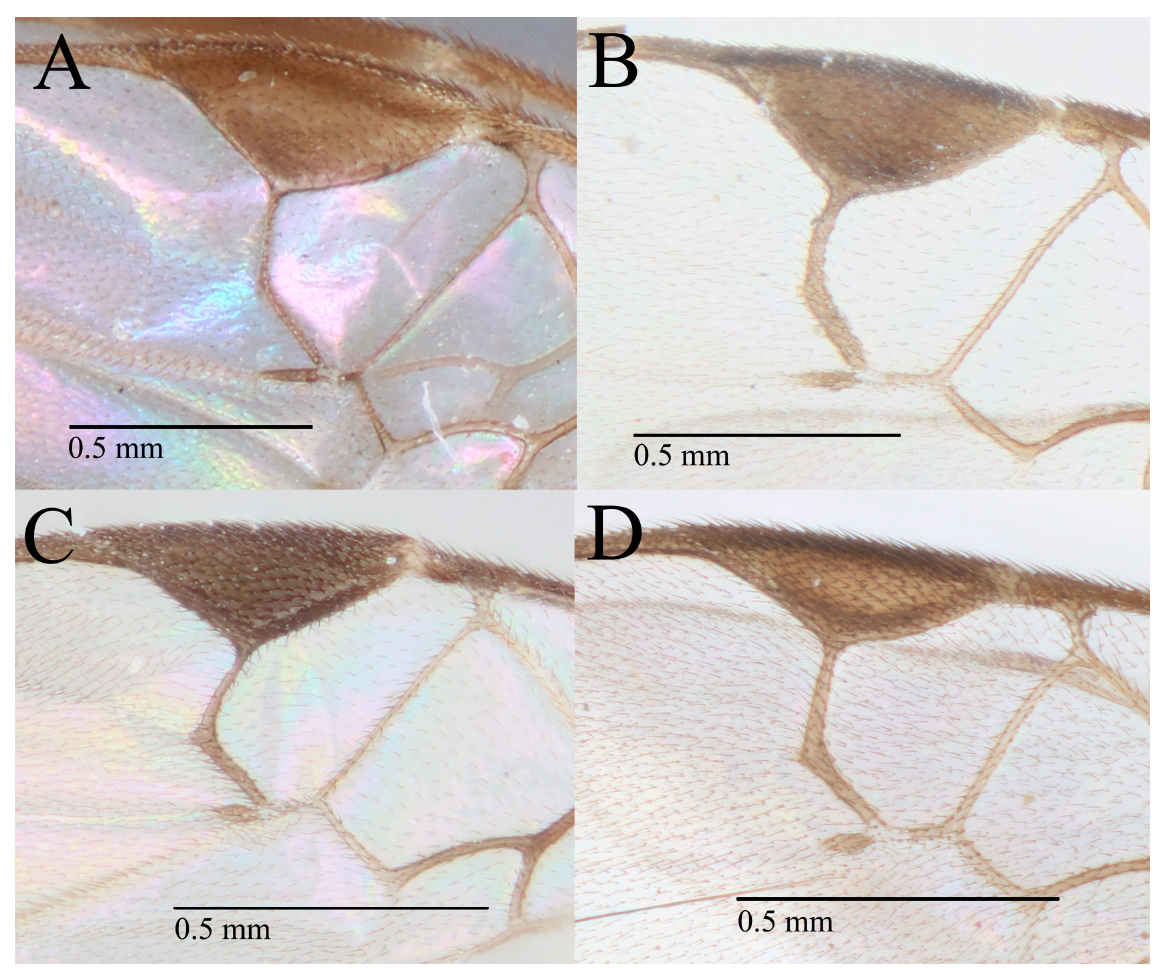
Fig. 11. A . Cotesia australiensis (Ashmead, 1900), fore wing vein r straight (ANIC 32 151532). B . C. scripta sp. nov., fore wing vein r subtly curved (holotype, MV T22495). C . C. lasallei sp. nov., fore wing vein r straight (holotype, SAMA 32-44401). D . C. medusae sp. nov., fore wing vein r straight (paratype QM